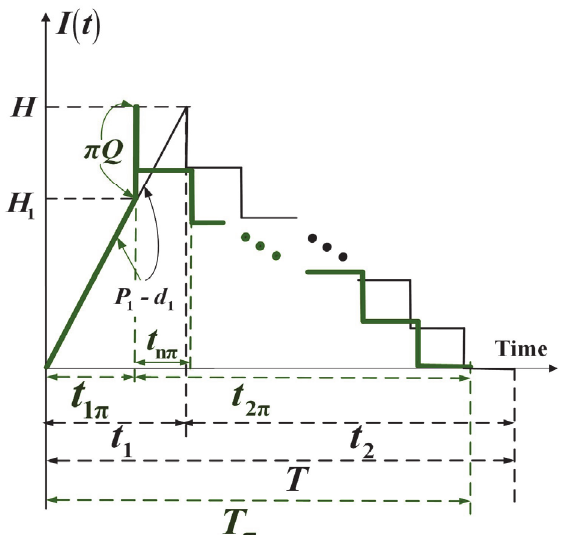
Fig. 6. The finished stock level in condition two of the proposed system (in green) as compared to that of the proposed system without outsourcing plan (in black)